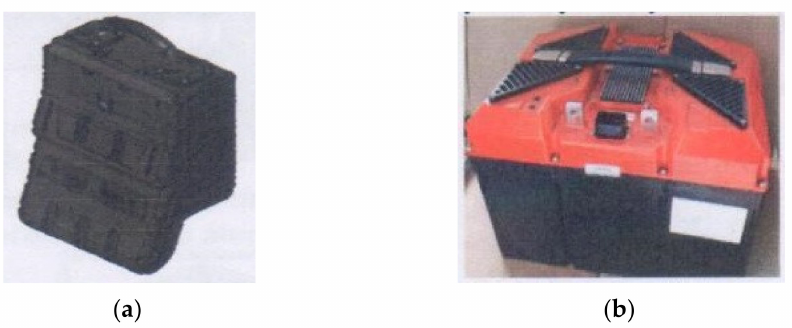
Figure 10. ( a ) NCA (Cylindrical) LIB, ( b ) LFP (Cylindrical)